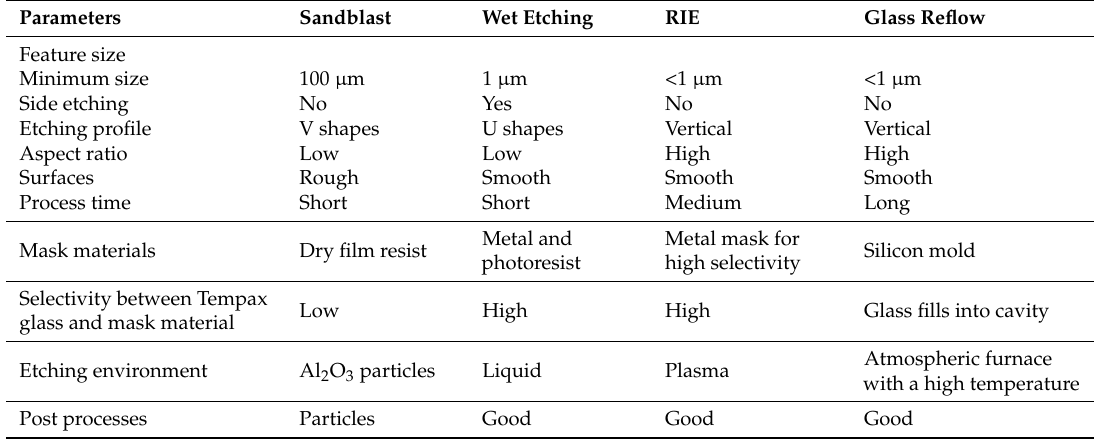
Table 2. Summarized advantages and disadvantages of glass micromachining.